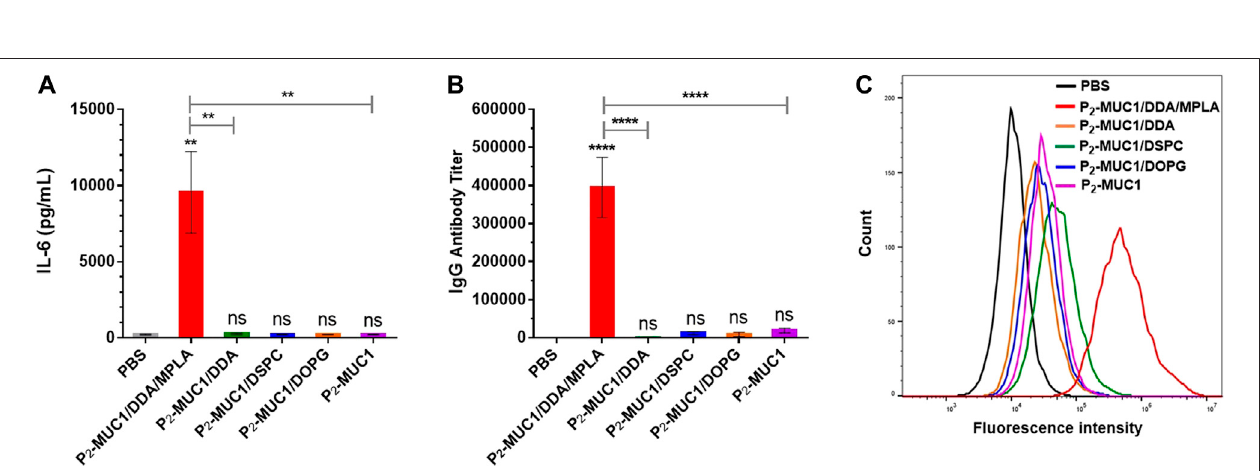
FIGURE5| Thesecretionsofcytokines (A) andMUC1-speci fi cIgGantibody (B) weredetectedbyELISA( n =5). (C) Flowcytometryhistogramsofthecellsstained withserafromPBSandthethirdimmunizationantiseracollectedfromP test. Comparisons between different groups were also conducted by ANOVA using Tukey ’ s HSD test. Data represent the mean ± SD of fi ve mice from three separate experiments.